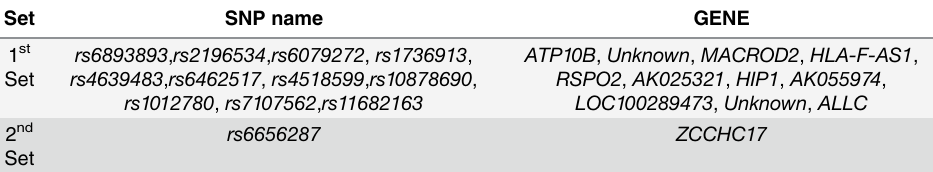
Table 5. KARE BMI data analysis result (Entrance cutoff = 5×10 − 5 , Removal cutoff = 5×10 − 5